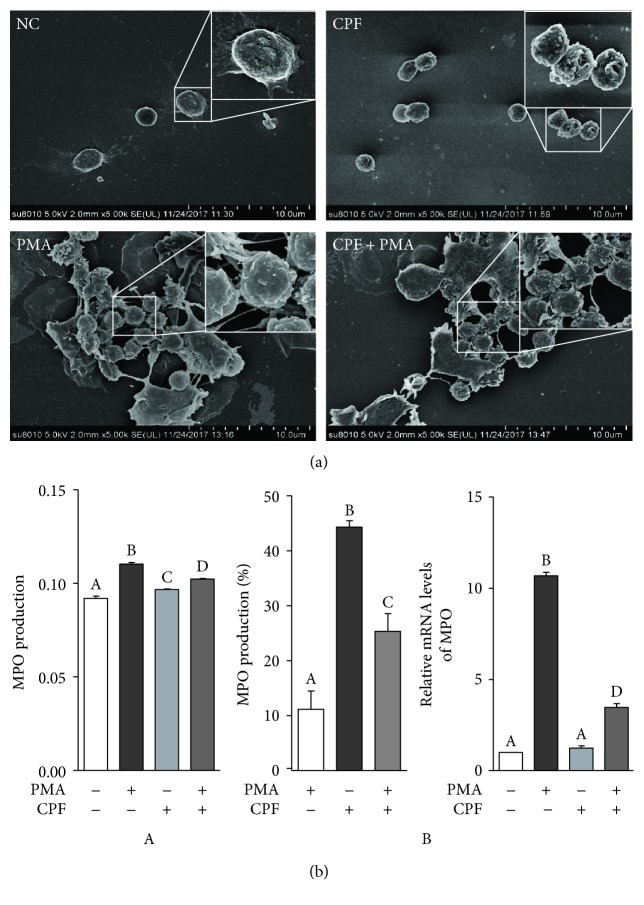
Production of NETs according to SEM and production of MPO in neutrophils after various treatments (a) Detection of NETs by scanning electron microscopy. (b) Effects of PMA or/and CPF on the production of MPO (A) and the mRNA levels of MPO (B) in neutrophils. The experiments were repeated three times. The data are presented as the mean ± SD. Bars with different letters were considered significantly different (P < 0.05).